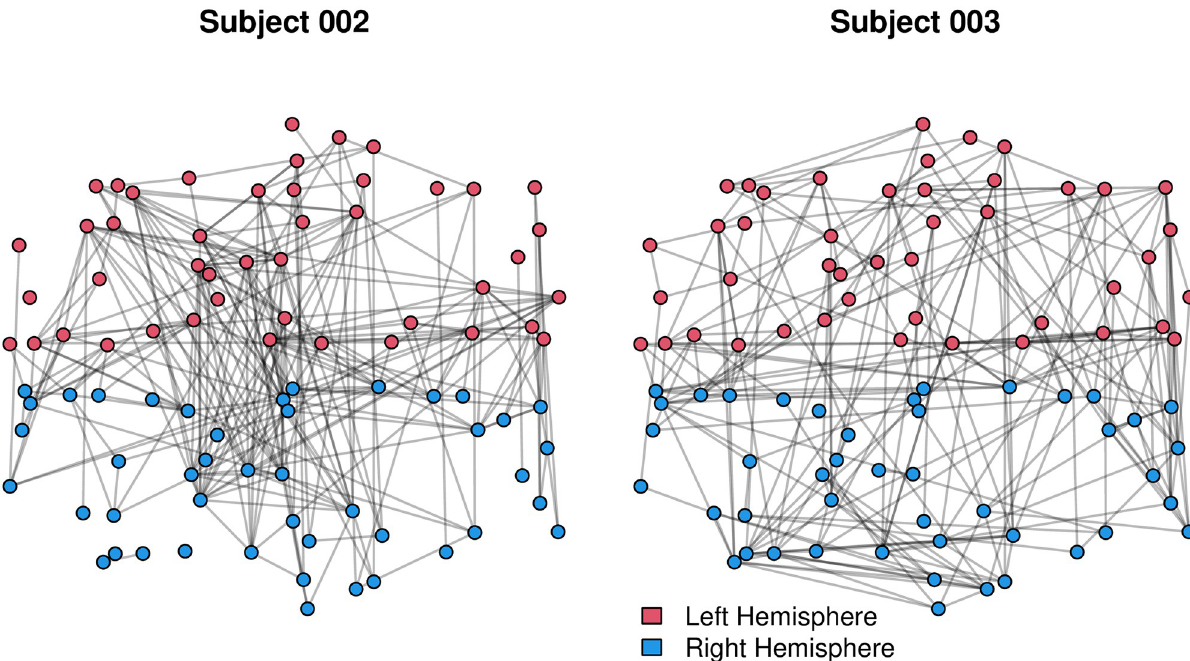
Fig 2. Brain connectivity networks of Subjects 002 and 003. Colors (red, blue) indicate the different hemispheres (left, right); node coordinates are based on an non-metric MDS [93] solution for distances between regions of interest.